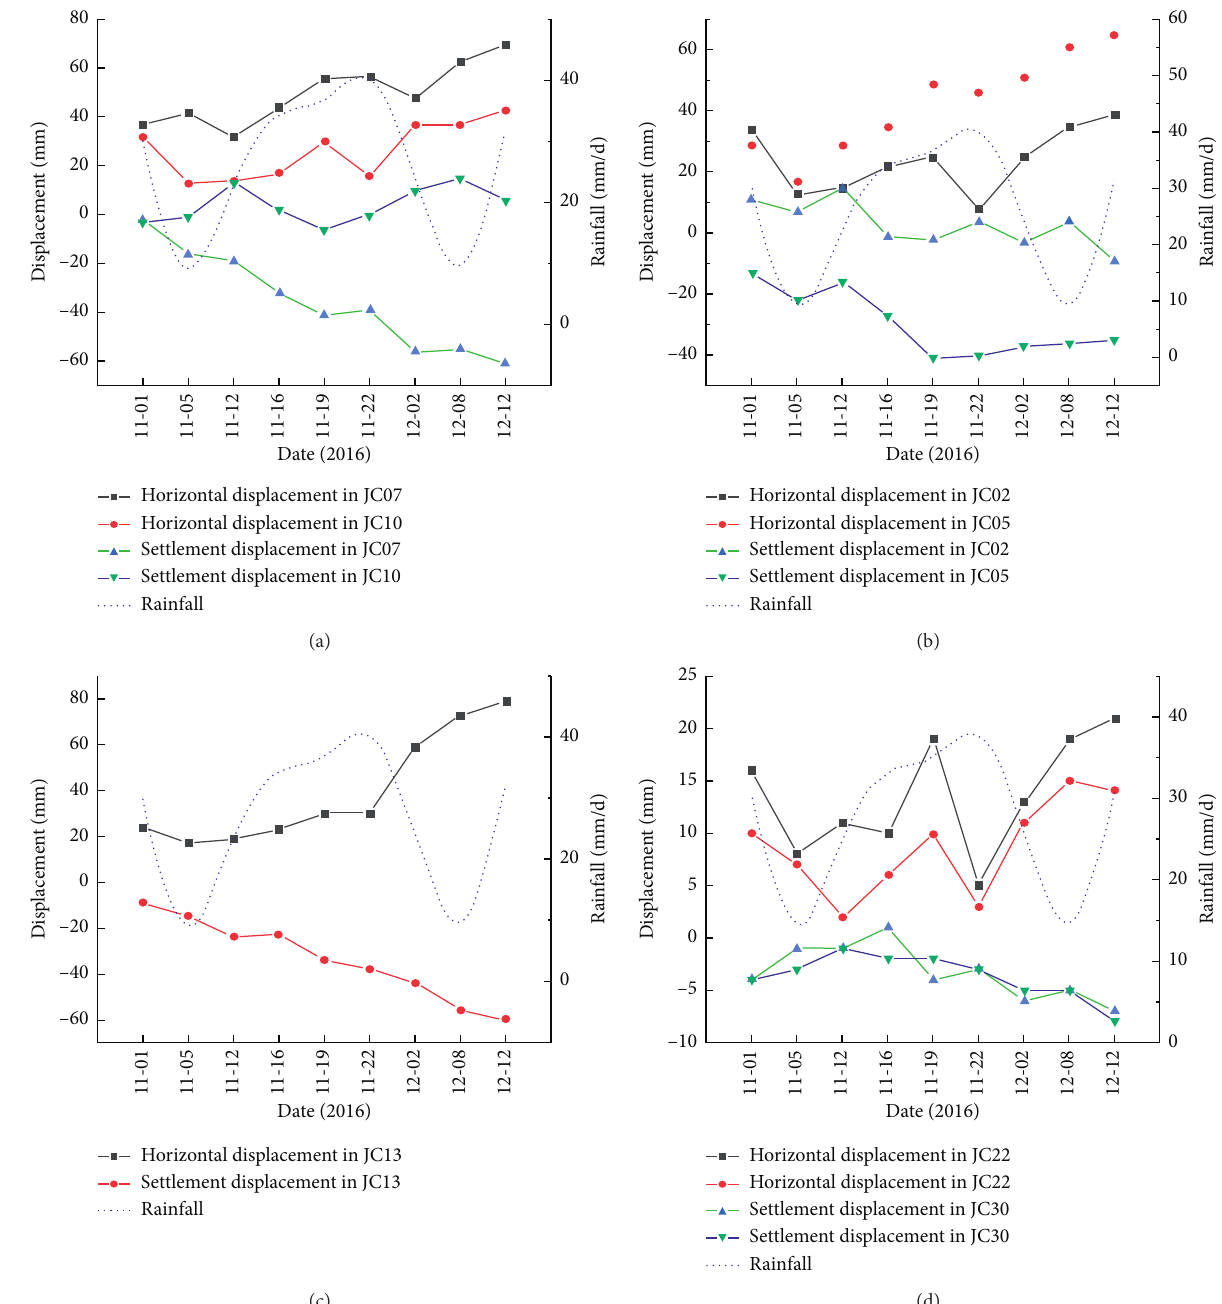
Figure 10: Monitoring data of the potential slide area for the Sucun